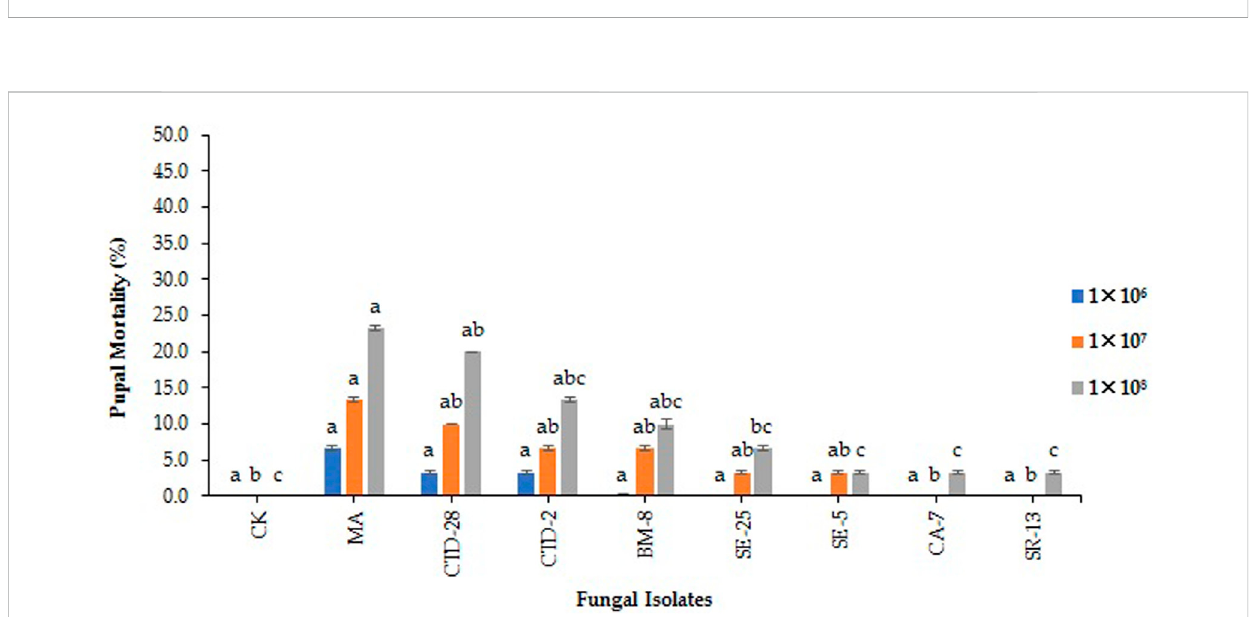
FIGURE 6 Effects of EPF on pupal mortality of fall armyworm treated with different concentrations at 14 days post treatment. Error bars denote the mean ± standard error at the 95% con fi dence interval. Means followed by the same letters are not signi fi cantly different by Tukey ’ s test at p < 0.05.